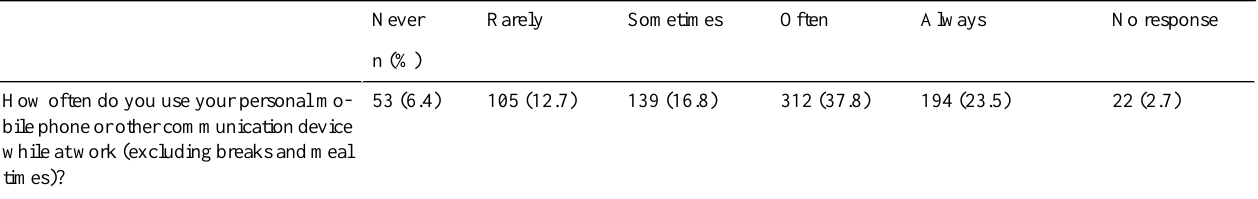
Table 1. Frequency of personal mobile phone or other communication device use while at work (n=825).